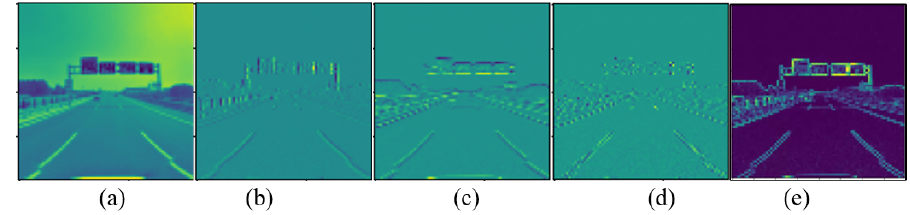
Figure 3. The visual feature map of the traffic sign image before and after reinforcement.